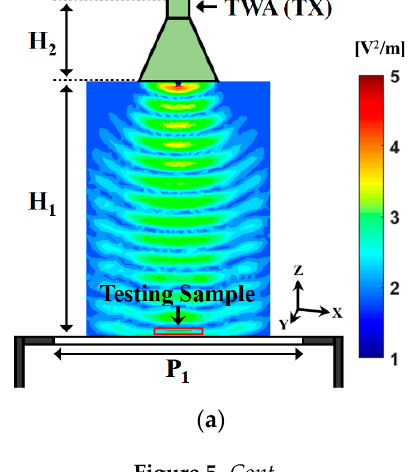
Figure 5. Cont. Figure 5.